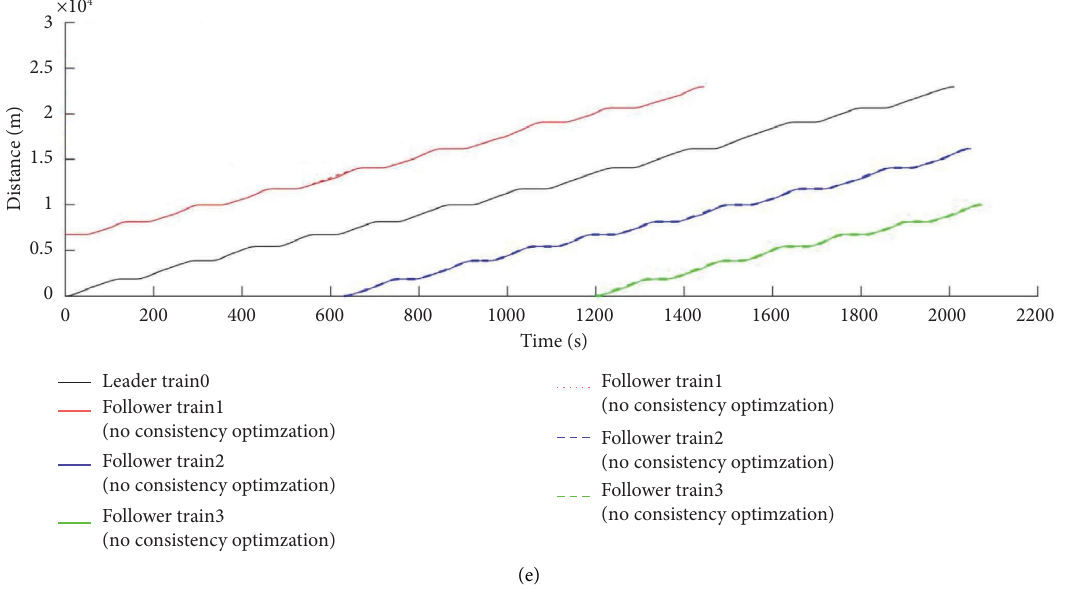
Figure 4: Running curves of 4 trains under consistent coordination state. (a) Time-velocity curve, (b) distance-velocity curve, (c) time- acceleration curve, (d) distance acceleration, and (e) time-distance